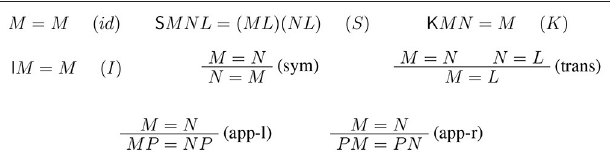
FIGURE 1 | Equational theory EQ